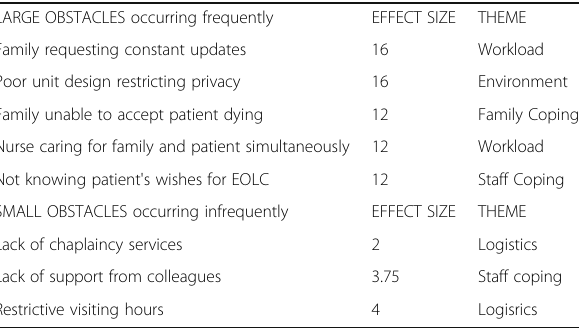
Table 23 (abstract A43). Effect size and themes obstacles LARGE OBSTACLES occurring frequently